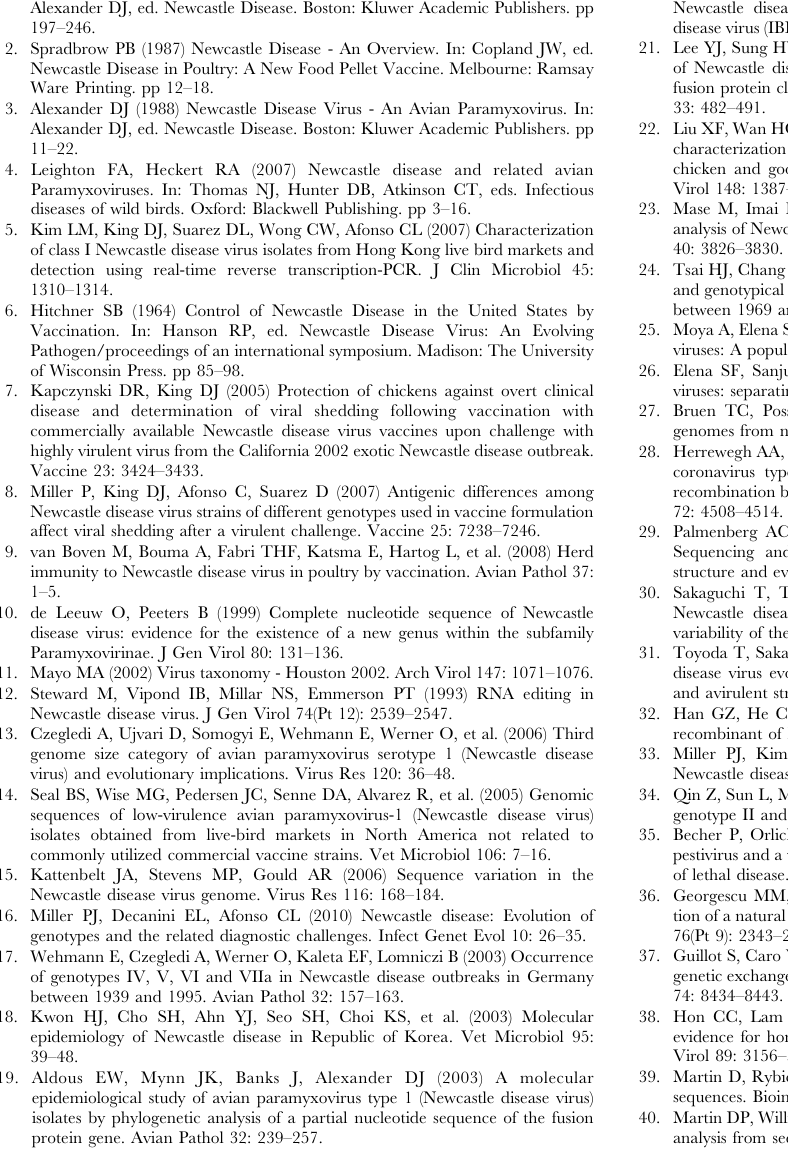
Table S3 The evolutionary rates and time to the most recent common ancestor (TMRCA) of each gene and concatenated genome based on GTR substitution model.